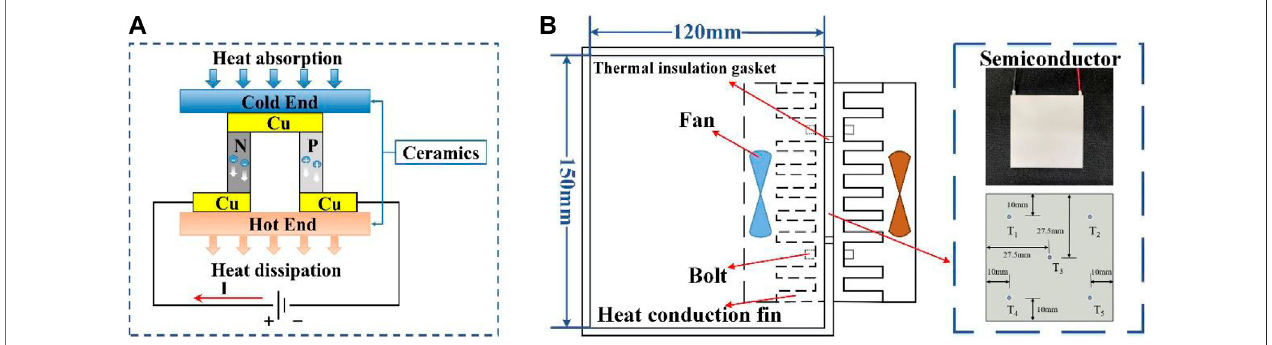
FIGURE 5 | (A) TEC operating principle; (B) Diagram of the semiconductor refrigeration